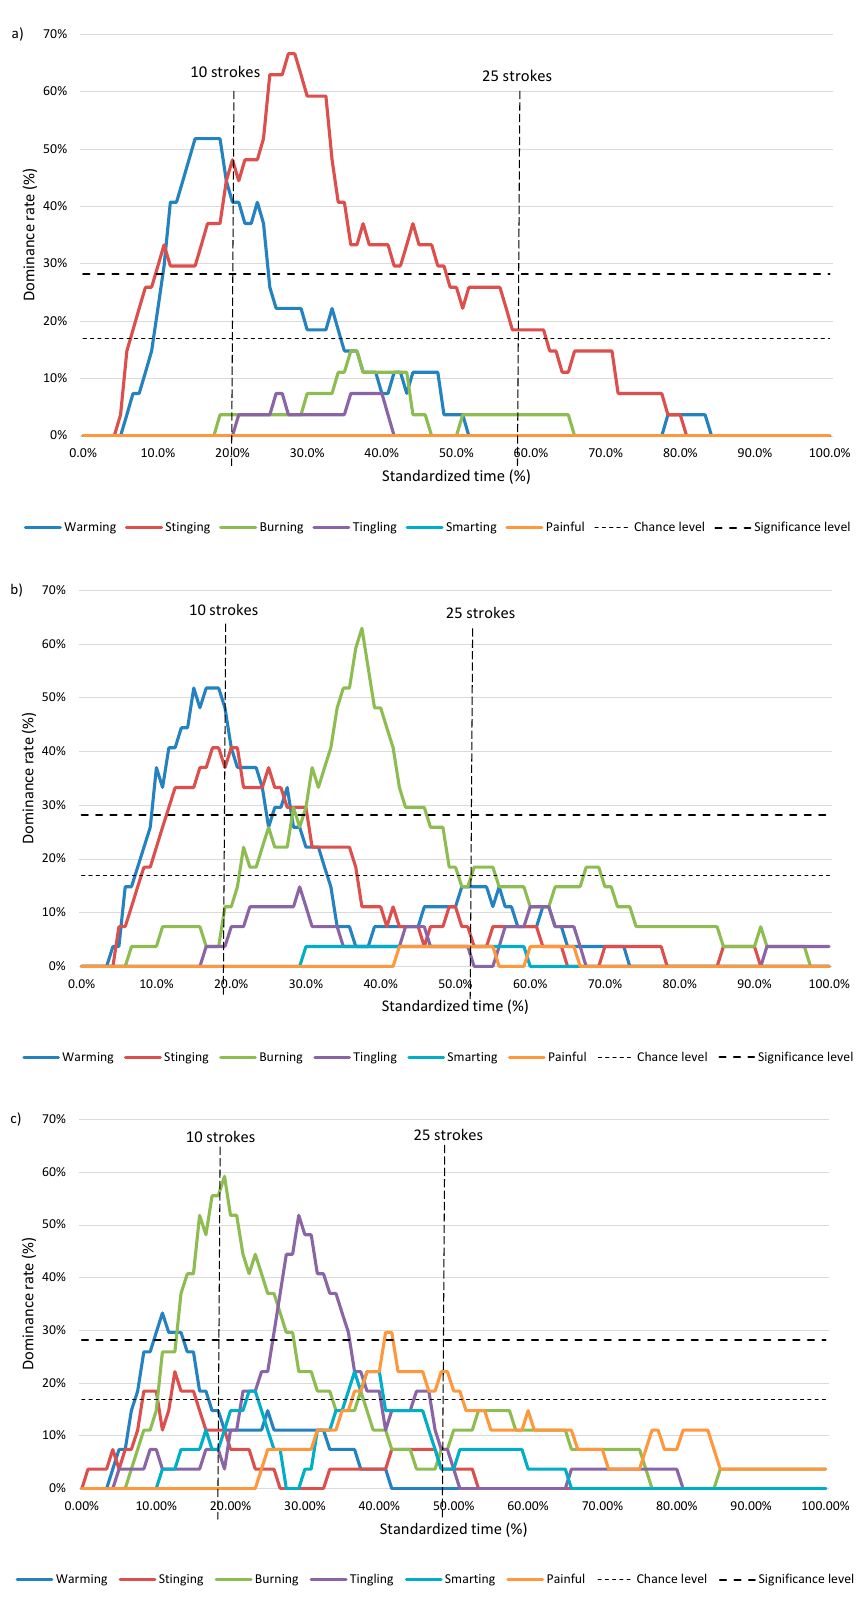
Figure 3. Temporal dominance pungency sensations (TDPS) curves for grilled pork meat with three different sauces: ( a ) Tabasco Brand Green Jalapeño Sauce; ( b ) Tabasco Brand Original Red Sauce; ( c ) Tabasco Brand Habanero Pepper Sauce. Defined time axis from t = 0 (first bite—0%) to t = 1 (swallowing—100%). Attributes are shown in different colors.